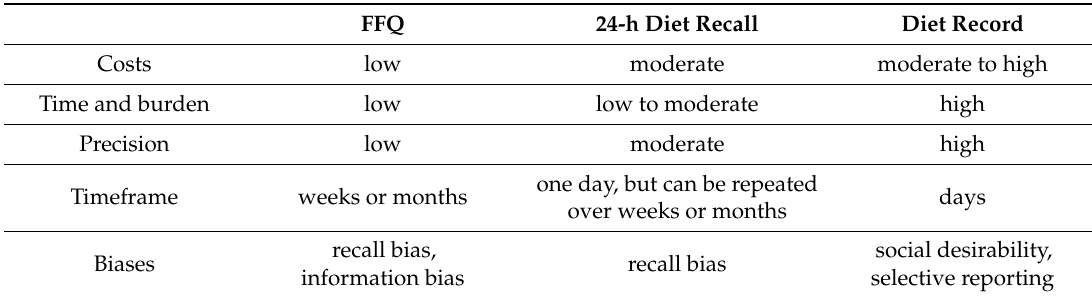
Table 1. Strengths and limitations of commonly used dietary assessment methods for estimation of sodium and potassium